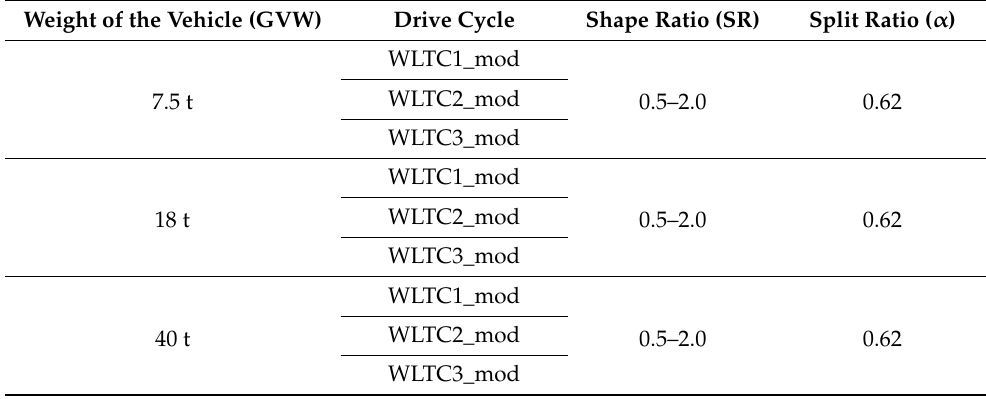
Table 2. Overview of all the use cases evaluated based on the weight of the vehicle, drive cycle, shape, and split ratio.